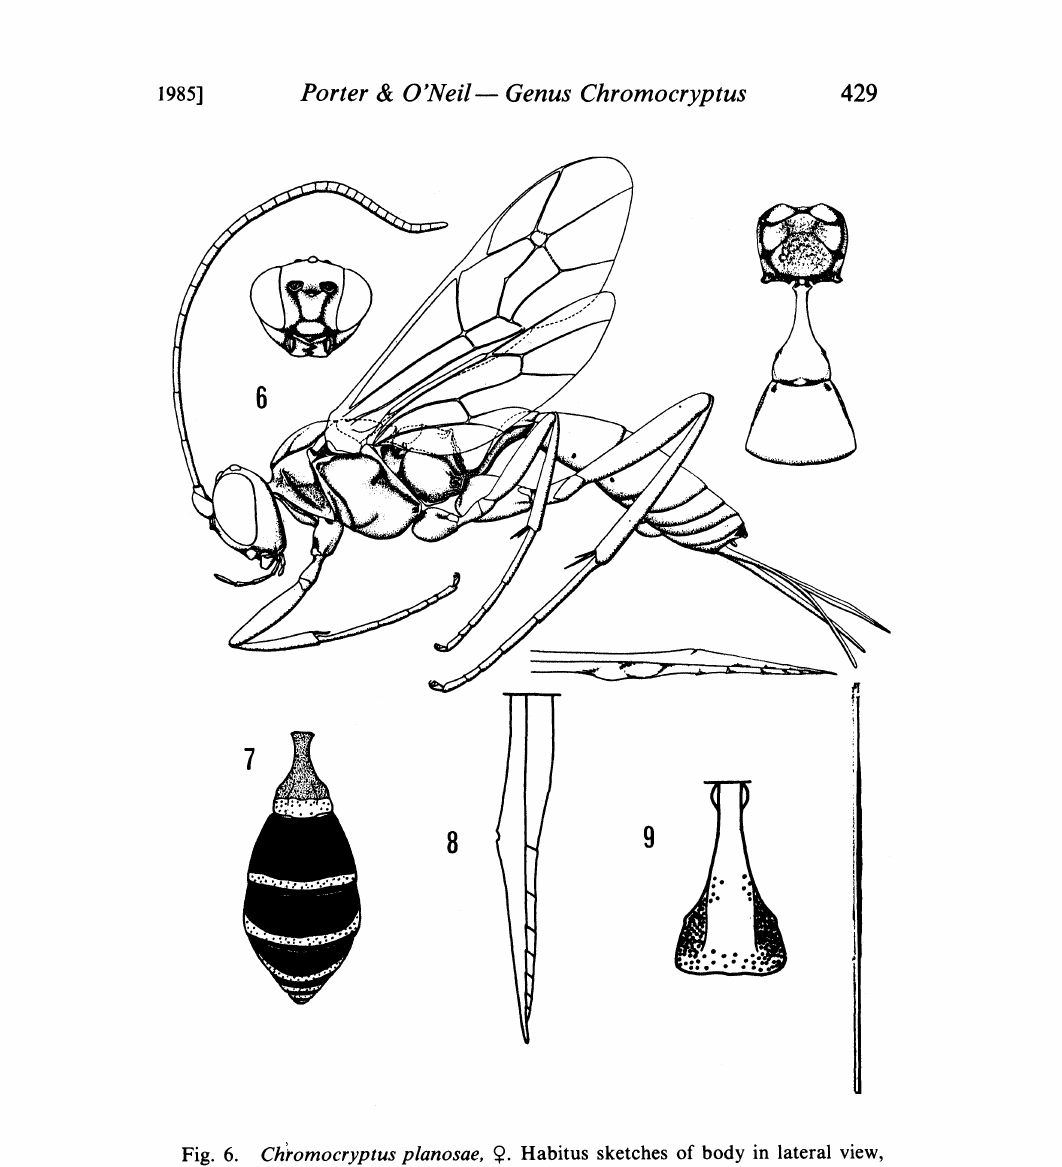
.. .. Habitus sketches of body in lateral view, Fig. 6. Chomocryptus planosae, .. head in anterior view, and propodeum with first two gastric tergites in dorsal view. .. Gaster in dorsal (From Towne 1962: 536). Fig. 7. Chromocryptus mesorufus, view, showing color pattern and habitus. (From Porter 1977: 40). Fig. 8. Chro- Ovipositor tip in lateral view. (From Porter 1967: Fig. 32). mocryptus hubbrichL Dorsal view of first gastric tergite. (From Fig. 9. Chroocryptus huebrichL Porter 1967: Fig.